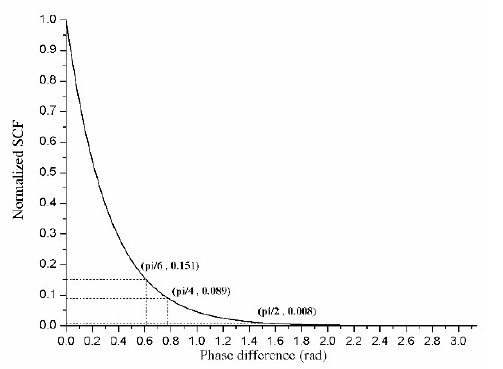
Figure 11. The curve of normalized SCF with respect to phase difference of two macro particles.